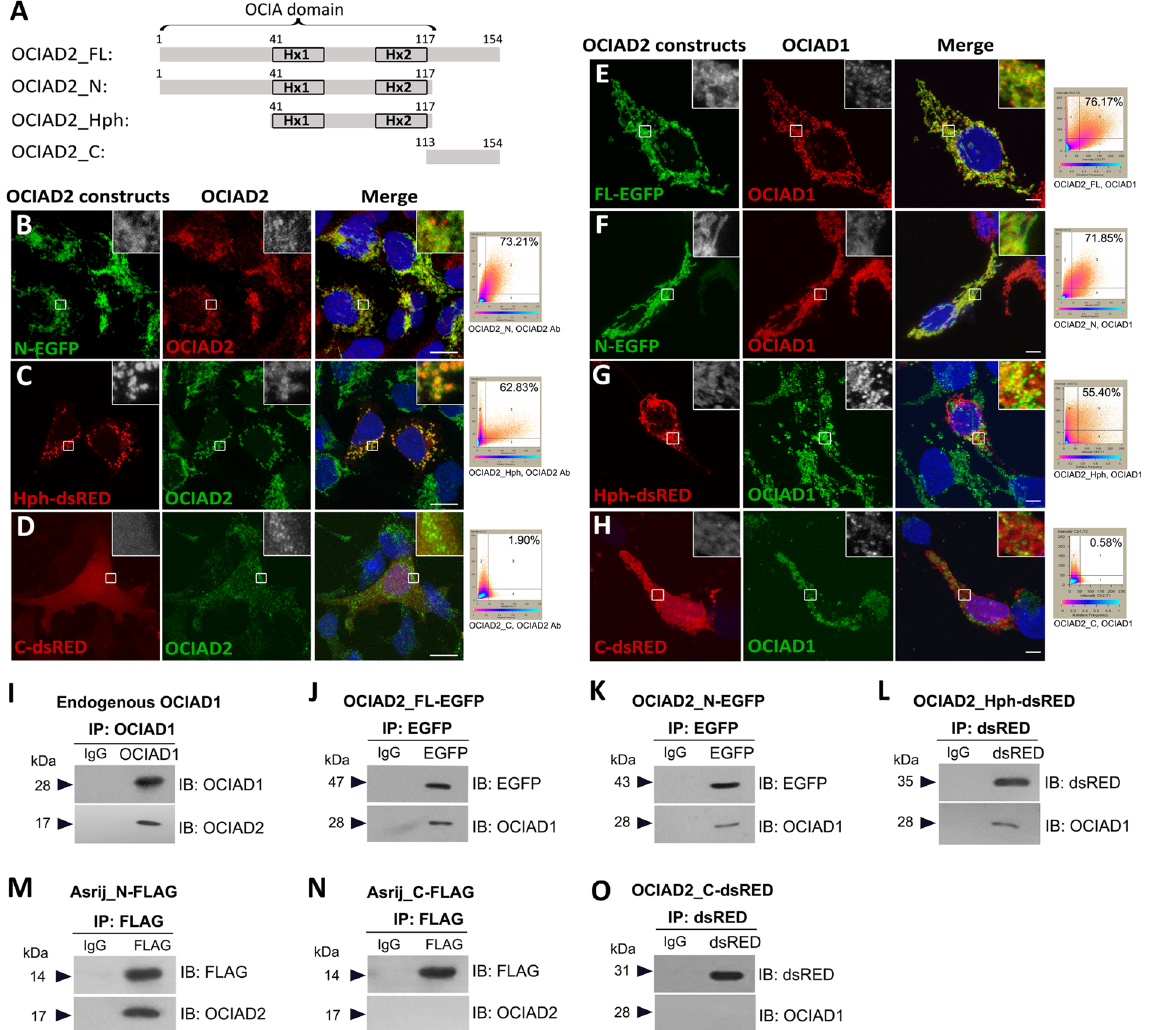
Figure 5. The double helical motif of OCIAD2 is necessary for interaction with OCIAD1. ( A ) Schematic representation of full-length (FL), N-terminal (N), hydrophobic region (Hph) and C-terminal (C) fragments of OCIAD2 generated for this study. Numbers indicate amino acid positions. Hx: predicted alpha helix. ( B – H ) Confocal images of HEK293 cells transfected with OCIAD2 reporter constructs, showing localization of ectopic OCIAD2-reporter with endogenous OCIAD2 ( B – D ) or endogenous OCIAD1 ( E – H ) as indicated, detected by fluorescence immunostaining with respective antibodies. Insets show magnified view of the boxed region. Co-localization plots are to the right of each panel. Scale bar: ( B – D ): 10 µ m; ( E – H ): 5 µ m. ( I – O ) Cell lysates from untransfected HEK293 cells (I) or those expressing various OCIAD2 (J, K, L, O) or OCIAD1/Asrij ( M , N ) constructs as indicated on the top of each panel, were subjected to immunoprecipitation (IP) followed by immunoblotting (IB) with antibodies as indicated. Protein size markers (in kDa) are indicated to the left. At least two independent immunoprecipitation experiments with two technical replicates each were performed and similar results were obtained. Full-length blots are presented in Supplementary Figure